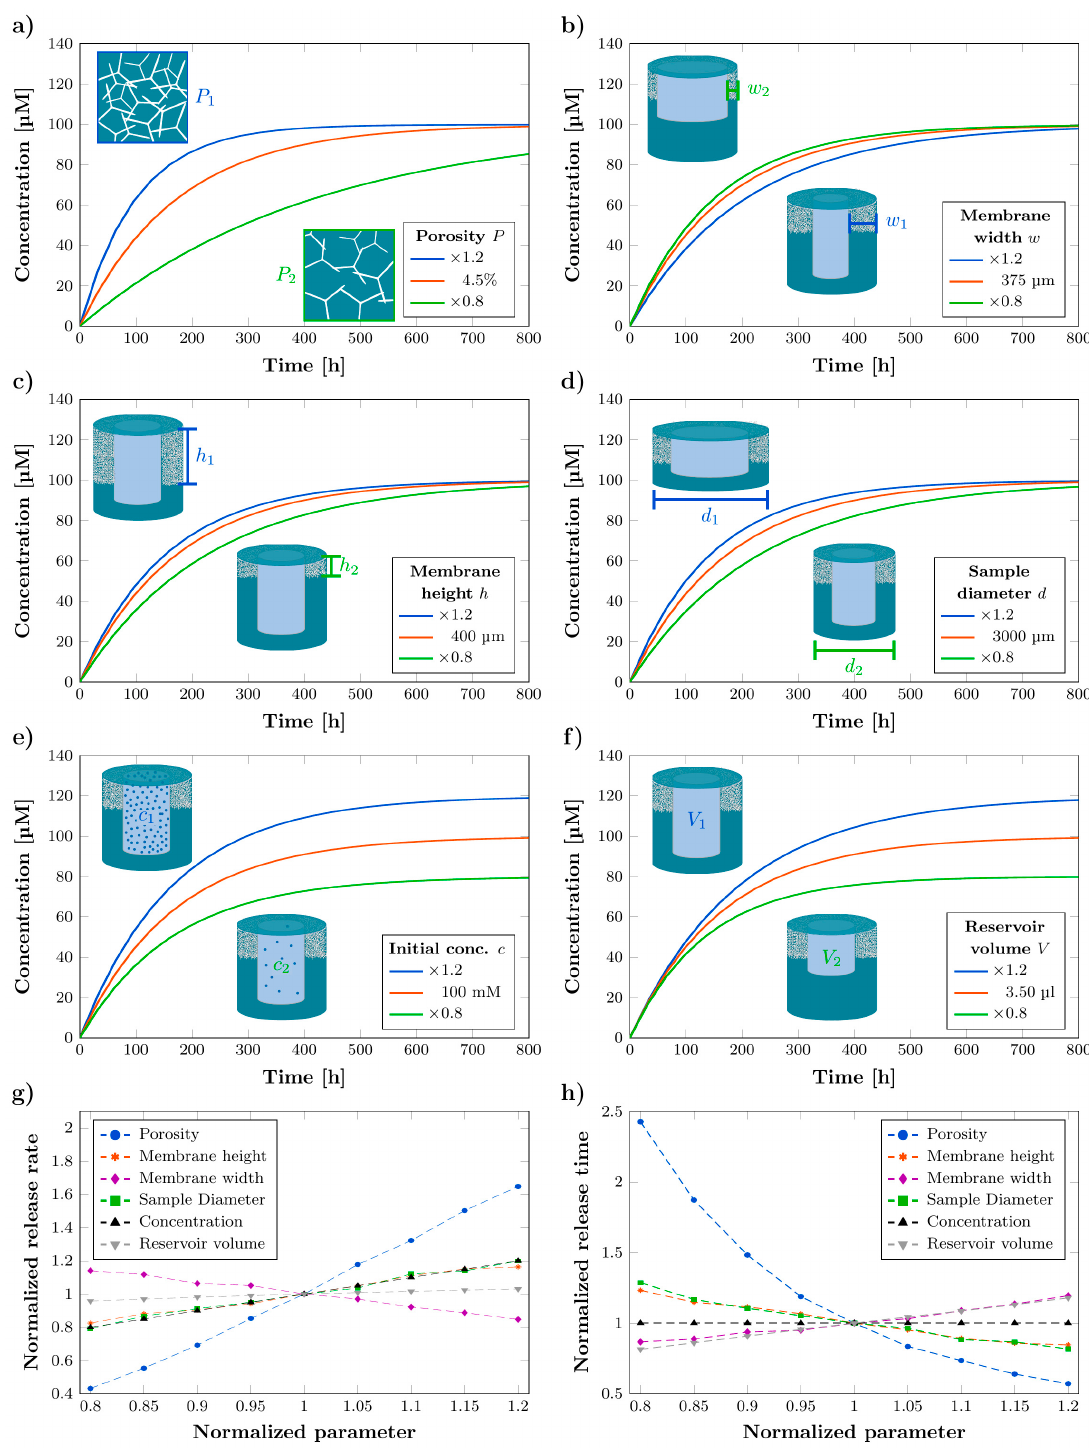
Figure 5. Simulated concentration curves showing the influence on the release kinetics by the ( a ) membrane porosity, ( b ) membrane width, ( c ) membrane height, ( d ) sample diameter, ( e ) initial concentration, and ( f ) reservoir volume. Red curves represent the concentration curve of the standard rDDS (compare Table 1) while blue and green curves show the concentration curves with +20% and − 20% deviation of the respective parameter. ( g ) The normalized release rate and ( h ) normalized release time, as a function of the adjustable parameters, normalized to their initial values (compare to Table 1).